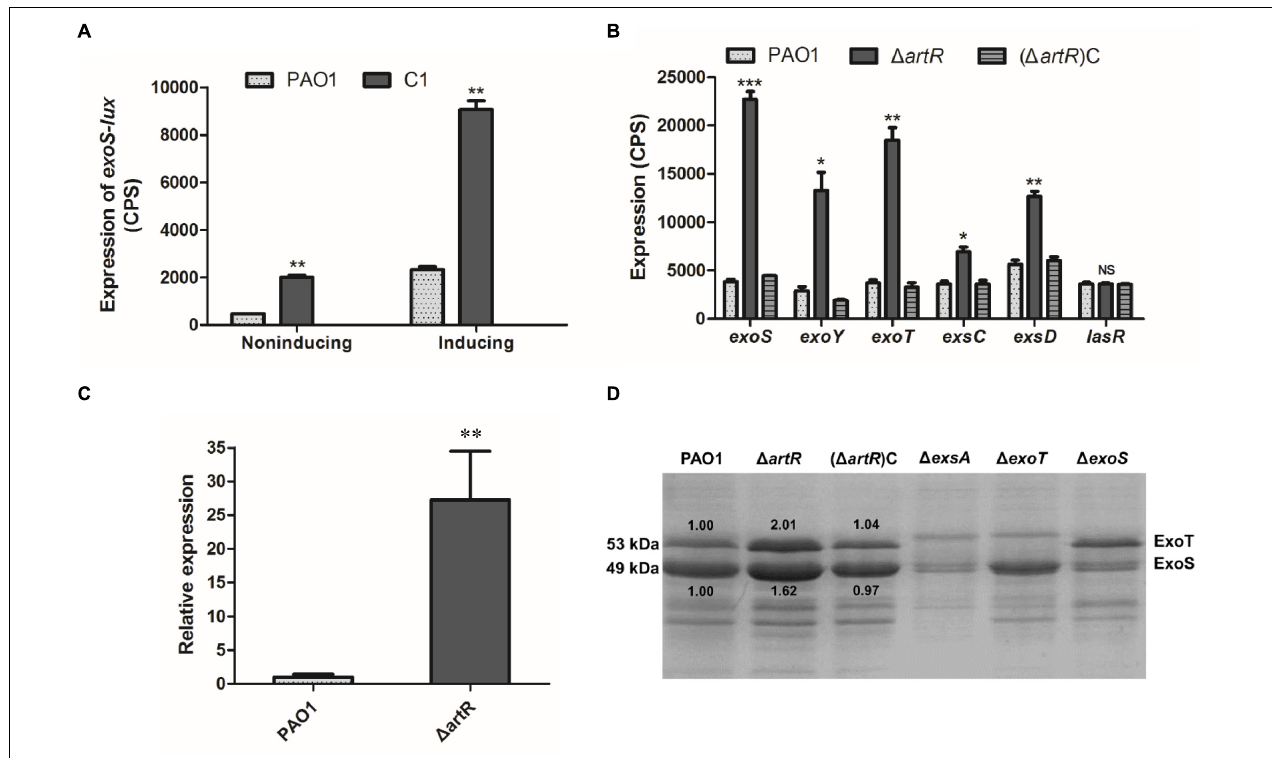
FIGURE 1 | Effect of artR mutation on T3SS expression and secretion. (A) A CTX- exoS reporter fusion integrated on the chromosome was used to measure expression levels of exoS under T3SS non-inducing or inducing conditions in C1 mutant strain and wild-type PAO1 after 6 h growth. Error bars indicate one standard deviation. ∗∗ p < 0.01 compared to the wild-type based on Student’s t -test. (B) Strains carried reporter plasmids pKD- exoS , pKD- exoY , pKD- exoT , pKD- exsC, or pKD- exsD were cultured under T3SS inducing conditions. Promoter activities were measured after 6 h growth. Error bars indicate one standard deviation. NS, p > 0.05, ∗ p < 0.05, ∗∗ p < 0.01, or ∗∗∗ p < 0.001 compared to the wild-type. (C) The RT-qPCR analysis of the normalized mRNA expression level of the exoS gene in the (cid:49) artR strain under T3SS inducing conditions. ∗∗ p < 0.01. (D) Culture supernatants of various strains after 6 h of growth in T3SS inducing medium were concentrated and analyzed by SDS-PAGE, followed by staining with Coomassie blue. The bands of approximately 53 and 49 kDa were corresponding to ExoT and ExoS respectively. The relative grayscale value of ExoS and ExoT bands were quantified using